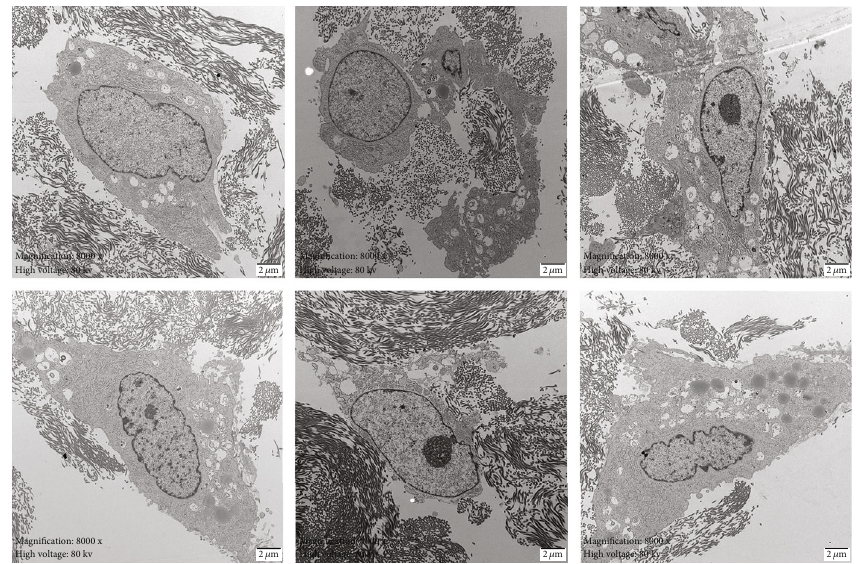
Figure 4: The cell-sca ff old complex was observed under a transmission electron